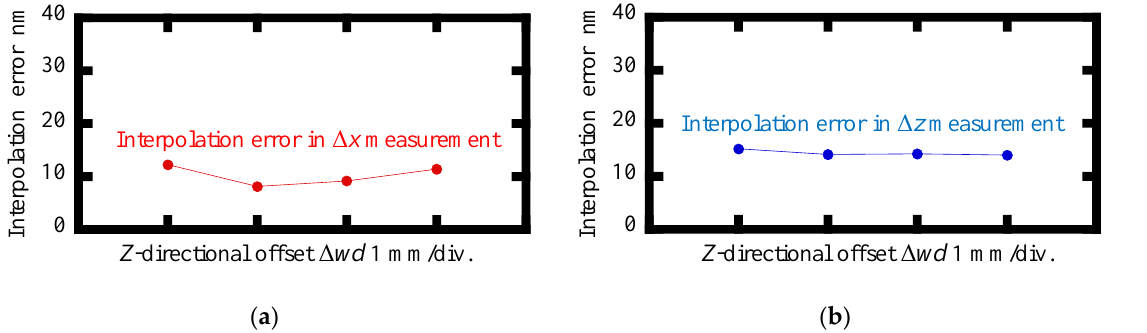
Figure 12. Variations of amplitudes of the interpolation errors when the Z - directional offset Δ wd was applied to the scale grating: ( a ) Δ x measurement; ( b ) Δ z measurement.